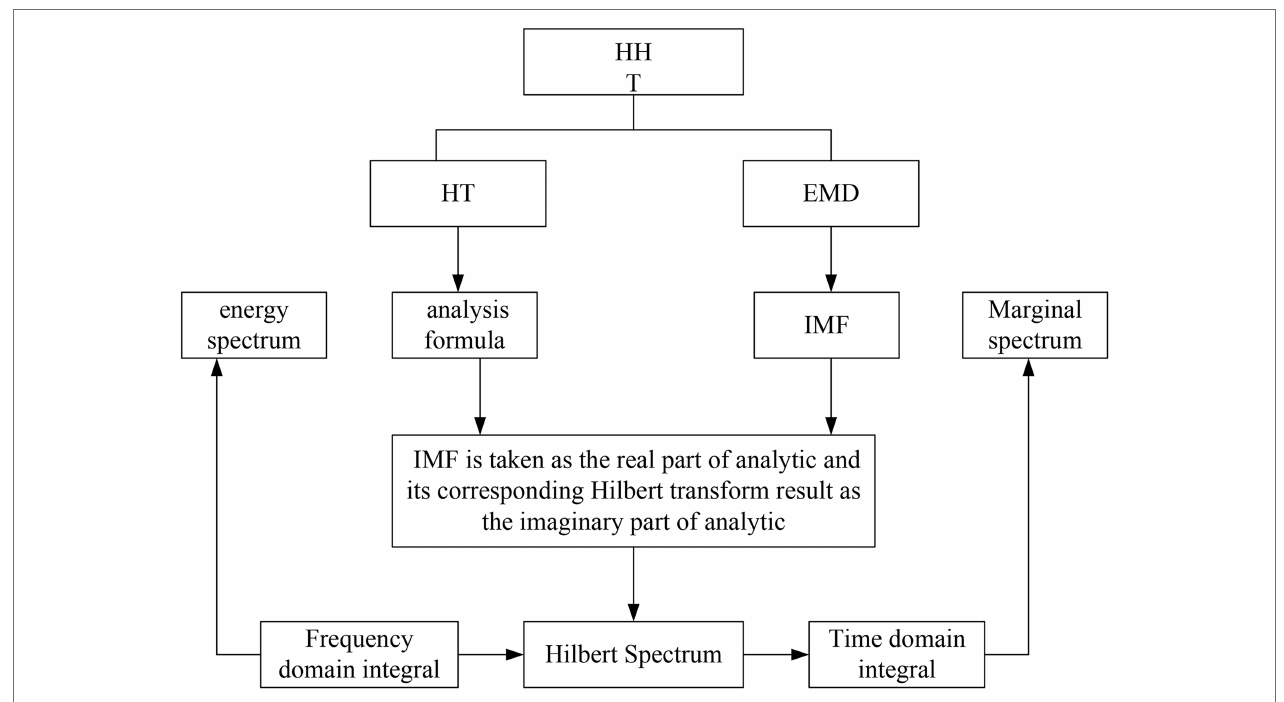
FIGURE 2 | The application process of HHT